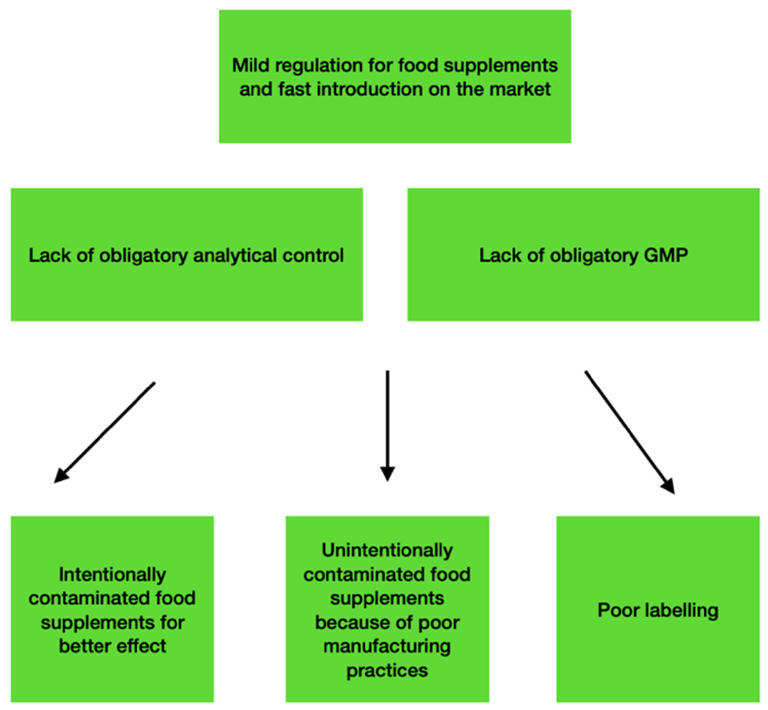
Figure 1. Food supplements as a source of unintentional doping.